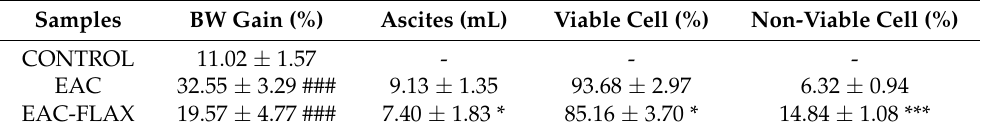
Table 3. Flaxseeds extract treatment effects on the body weight, ascites volume, and viable/nonviable cell count at the end of the